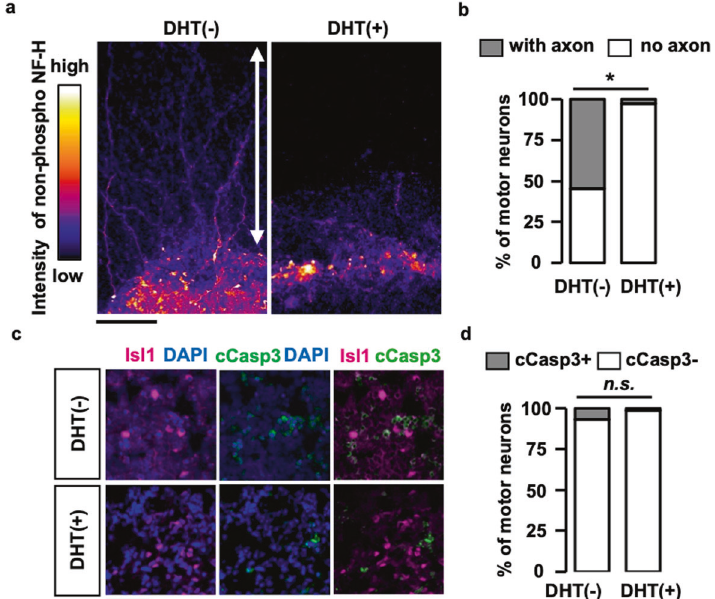
Fig. 5 Motor axons affected in the spinal cord slice culture from SBMA mice. a Intensity-coded images of non-phosphorylated NF-H. The double-headed arrows indicate the region of collagen gel where axons are embedded. b Motor neuronal cell bodies positive for non- phosphorylated NF-H were classi fi ed either with axon or no axon. Statistically, signi fi cant difference was detected in the percentage of motor neuronal cell bodies with axons ( n > 30 per group) by Fisher ’ s exact test (* p < 0.001). c Immunostaining of cleaved caspase 3 (cCasp3) in the spinal cord slice cultures of AR-97Q mice with or without DHT treatment. Immunostaining of cCasp3 is nearly absent in Isl1-positive motor neurons under DHT treatment. d Quanti fi cation of motor neuronal nuclei ( n > 50 per group) positive for cCasp3 with or without DHT treatment. No statistically signi fi cant difference was detected by Fisher ’ s exact